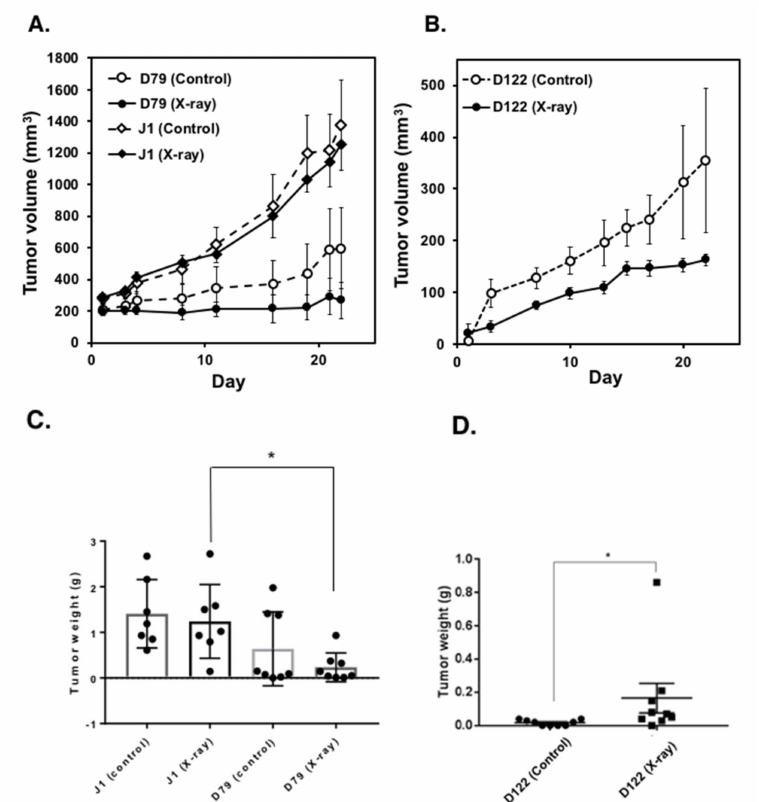
Figure 4. E ff ect of Parg deficiency on therapeutic e ffi cacy of X–irradiation on tumors derived from ES cells. Tumors of one of the hinder leg pair were subjected to local X–irradiation with a single dose at 7 Gy (( A , C ): n = 7 for wild-type (J1), n = 8 for Parg − / − (D79). ( B , D ): n = 9 for wild-type (J1) and Parg − / − (D122)). Tumor growth of non-irradiation controls (Control) was monitored for non-irradiated side of hinder leg pair. Tumor growth was observed for 22 days. ( A , B ) Tumor growth curve, Mean ± S. E. ( C , D ) Measured tumor weight 22 days after injection of ES cells, Mean ± S. E. ( C ) Statistical analysis was carried out with Turkey’s test. * p < 0.05. ( D ) Statistical analysis was carried out with Mann–Whitney U -test. * p <